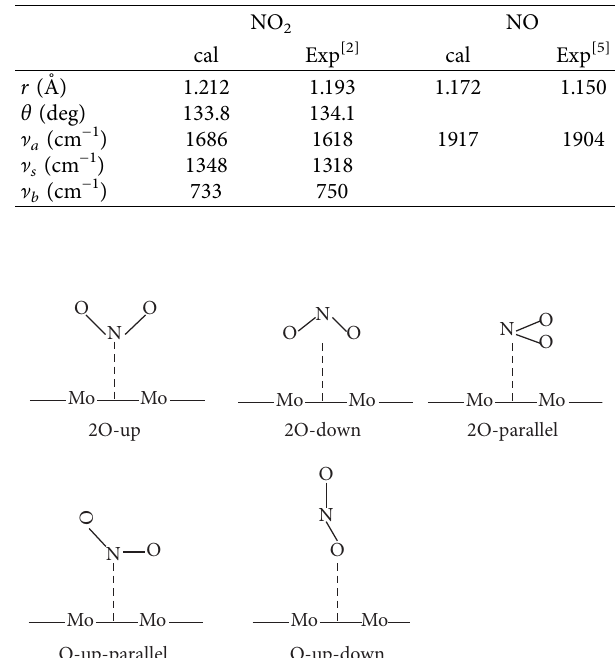
Table 1: The structural parameters and vibrational frequencies of gas-phase NO 2 and NO molecules.